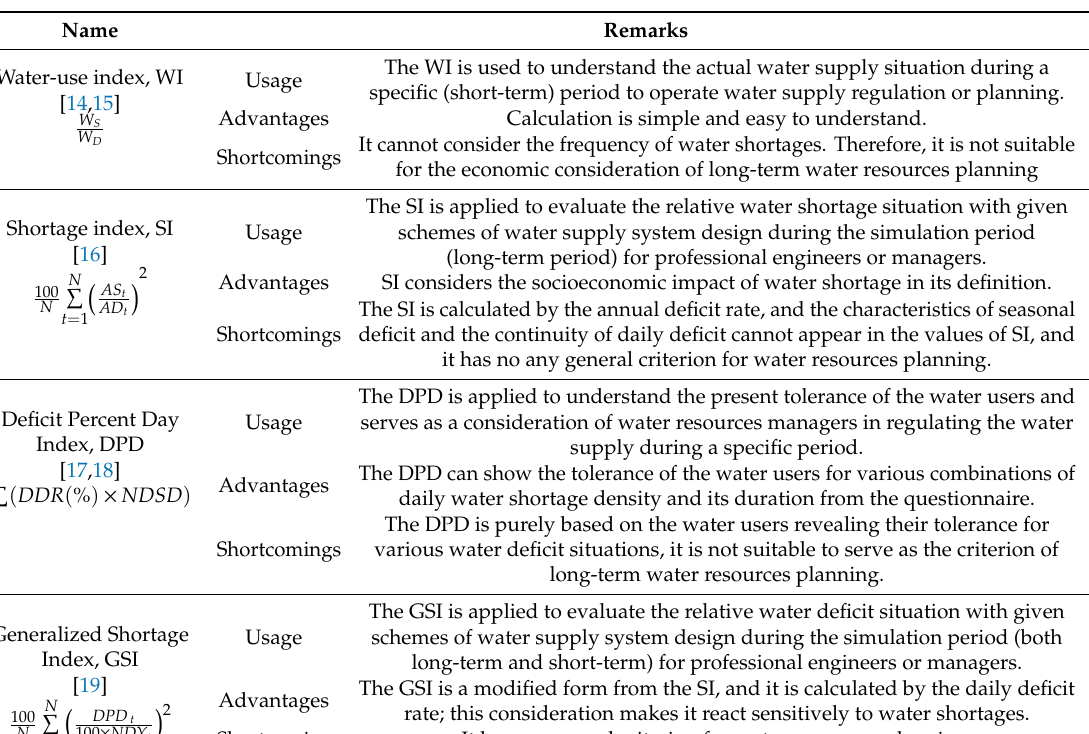
Figure 1. Definition sketch of water shortage characteristics of reservoir water supply process. Table 1. The comparison of four common water shortage evaluation